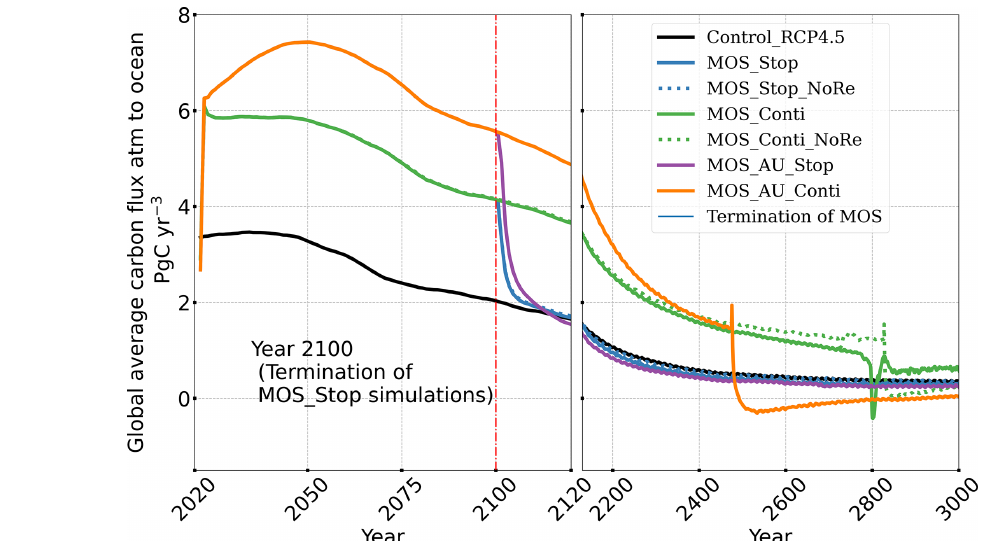
Figure B11. Global averaged carbon flux from atmosphere to ocean.